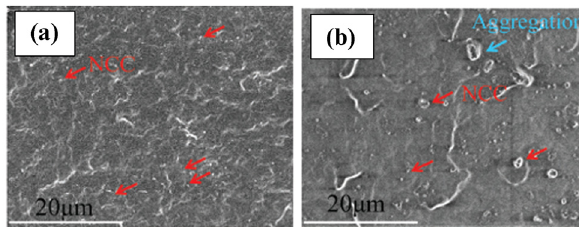
Figure 2: SEM micrographs of freeze - fractured surfaces of ( a ) CNC - g - PHBH ( 1.0 wt% ) blend and ( b ) CNC - g - PHBH ( 2.0 wt% ) blend. Adapted from ref. [ 29 ] .